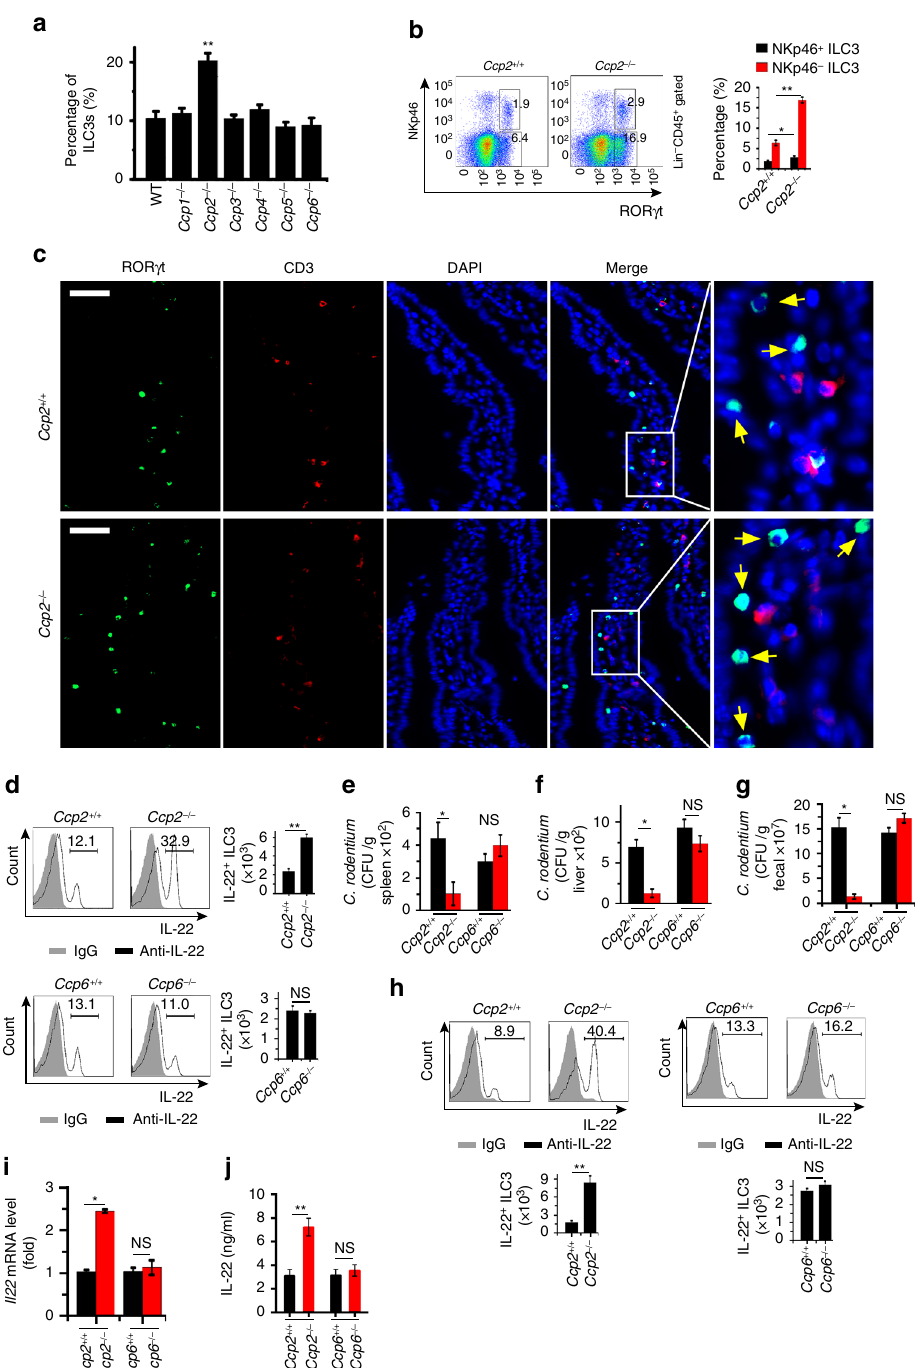
Fig. 1 CCP2 de fi ciency increases ILC3 numbers. a Percentages of ILC3s (Lin − CD45 + ROR γ t + ) in small intestine lamina propria from wild-type (WT), Ccp1 − / − , Ccp2 − / − , Ccp3 − / − , Ccp4 − / − , Ccp5 − / − , and Ccp6 − / − mice were analyzed by fl ow cytometry. n = 6 for each group. b Analysis of NKp46 + ILC3s (Lin − CD45 + ROR γ t + NKp46 + ) and NKp46 − ILC3s (Lin − CD45 + ROR γ t + NKp46 + ) from Ccp2 +/+ and Ccp2 − / − mice by fl ow cytometry. n = 6 for each group. c Analysis of ILC3s in Ccp2 +/+ and Ccp2 − / − small intestines by immuno fl uorescence staining. Arrowhead denotes ILC3 cells. Scale bars , 50 μ m. d Analysis of IL-22 + ILC3 in WT, Ccp2 − / − , and Ccp6 − / − small intestines after IL-23 stimulation. Cells were gated on Lin − IL-22 + . n = 6 for each group. e – g C. rodentium titers in spleen e , liver f , and fecals g from WT, Ccp2 − / − and Ccp6 − / − mice 8 day after infection. h Analysis of IL-22 + ILC3 in WT, Ccp2 − / − , and Ccp6 − / − small intestines after C. rodentium infection. n = 6 for each group. i Il22 expression was detected by real-time qPCR after C. rodentium infection. n = 6 for each group. j 1 × 10 4 ILC3s (Lin − CD45 lo CD90 hi ) isolated from WT, Ccp2 − / − and Ccp6 − / − intestines were cultured at 37 °C in vitro for 24 h in the presence of IL-23. IL-22 was examined by ELISA. n = 6 per group. * P < 0.05, ** P < 0.01 (Student ’ s t -test). NS, no signi fi cant. Data are representative of three independent experiments. Error bars in a , b , and d – j indicate